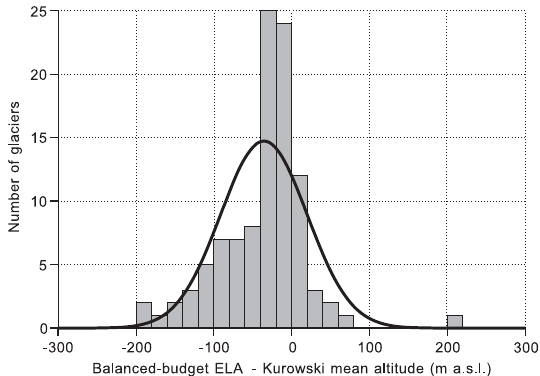
Figure 7. Histogram of errors between balanced-budget ELA and Kurowski mean altitude for 103 glaciers. The bold line denotes a Gaussian curve with the same mean and standard deviation as the plotted